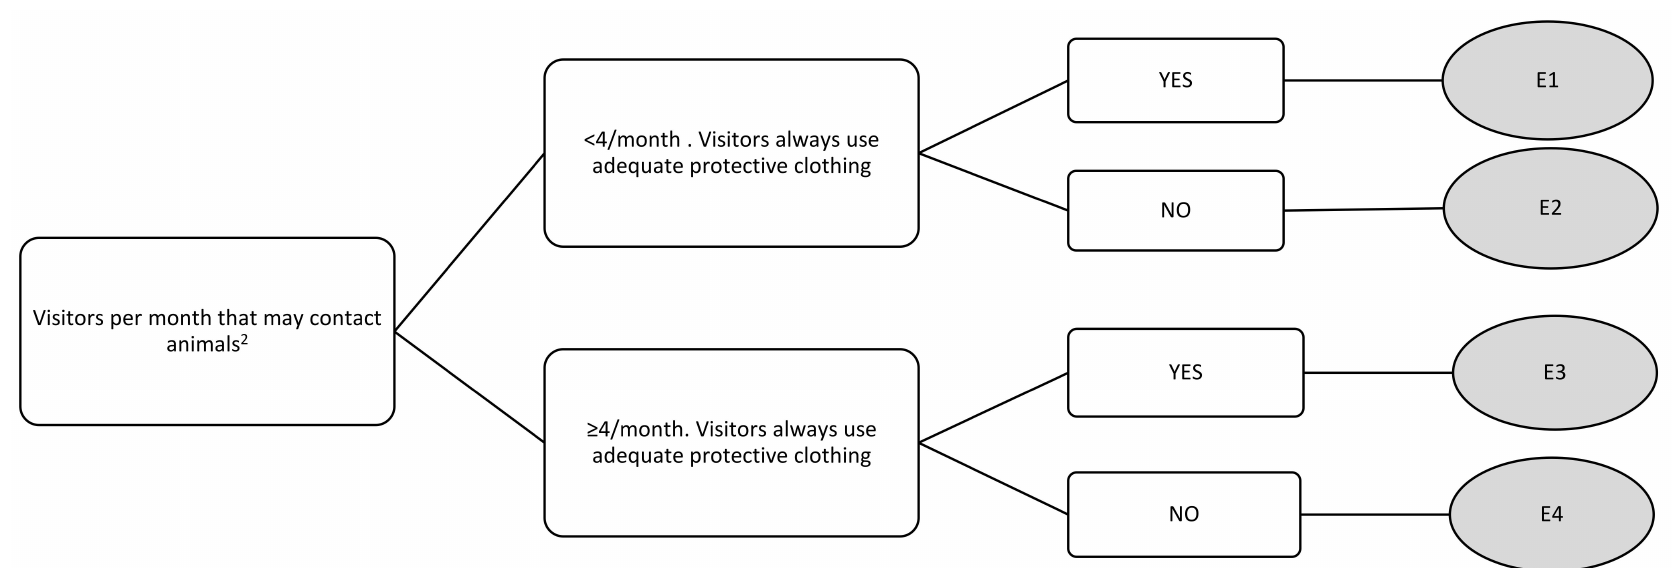
Figure A1. Decision tree diagrams. The sanitary status of the origin herd was considered known if it had a testing protocol comparable or superior to that in the herds in the control program in Galicia (negative when all animals tested negative in all tests performed in the last sampling campaign prior to the purchase of the animals or positive if at least one animal tested positive in any test). The sanitary status of the origin herd was considered unknown in any other case (either no testing protocols or testing protocols inferior to those implemented in Galicia). The median frequency of entries in those farms that purchase cattle in the study population is three. 1 Tractors, wagons, cistern, slurry whisk, baler or calving, cleaning, or harvesting materials. 2 The median number of visitors in the study population is four. Adequate protective clothing was defined as clean coveralls or overcoats and boots that are provided by the farmer before entering the cattle